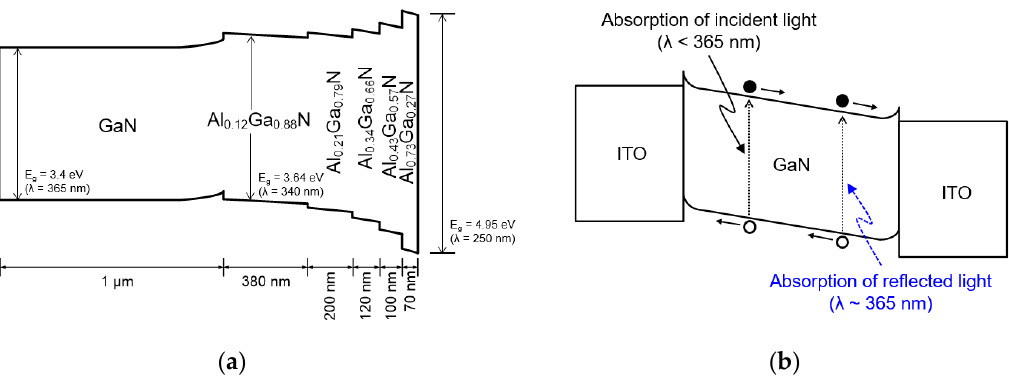
Figure 6. Energy band diagram of ( a ) the epitaxial structure of the GaN layer with the step-graded Al x Ga 1 − x N buffer layer; ( b ) GaN MSM UV photodetector under 365-nm UV irradiation with reflection and reabsorption effect of incident light.